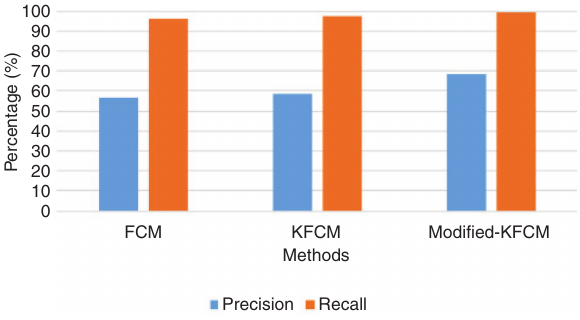
Figure 8: Graphical comparison of precision and recall.